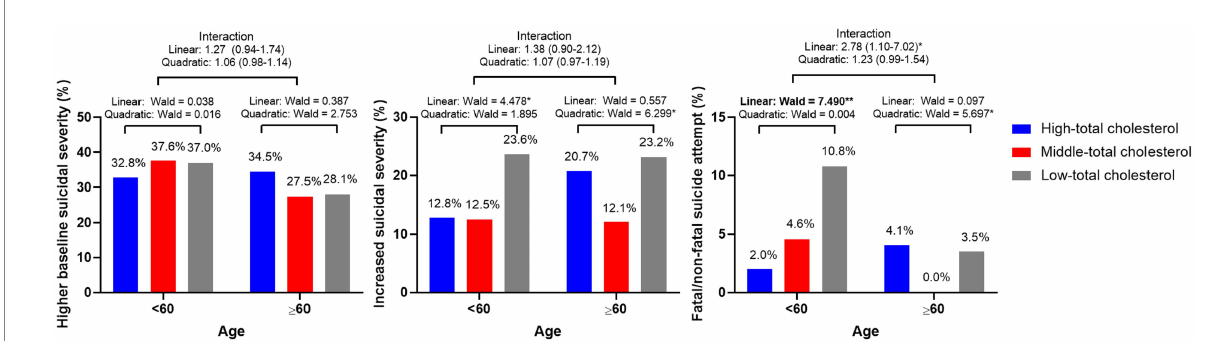
FIGURE 2 Adjusted linear and quadratic associations of serum cholesterol levels with suicidal behaviors according to age group. Figure legend: Data represent Wald scores or odds ratios (95% confidence intervals) after adjustment for sex, educational level, living alone, religious observance, body mass index (BMI), melancholic features, atypical features, duration of illness, recurrent depression, family history of depression, childhood abuse, number of physical disorders, and Hospital Anxiety Depression Scale-Anxiety Subscale (HADS-A) and Perceived Stress Scale (PSS) scores. * p < 0.05 and ** p < 0.01. Bold style denotes statistical significance after bonferroni